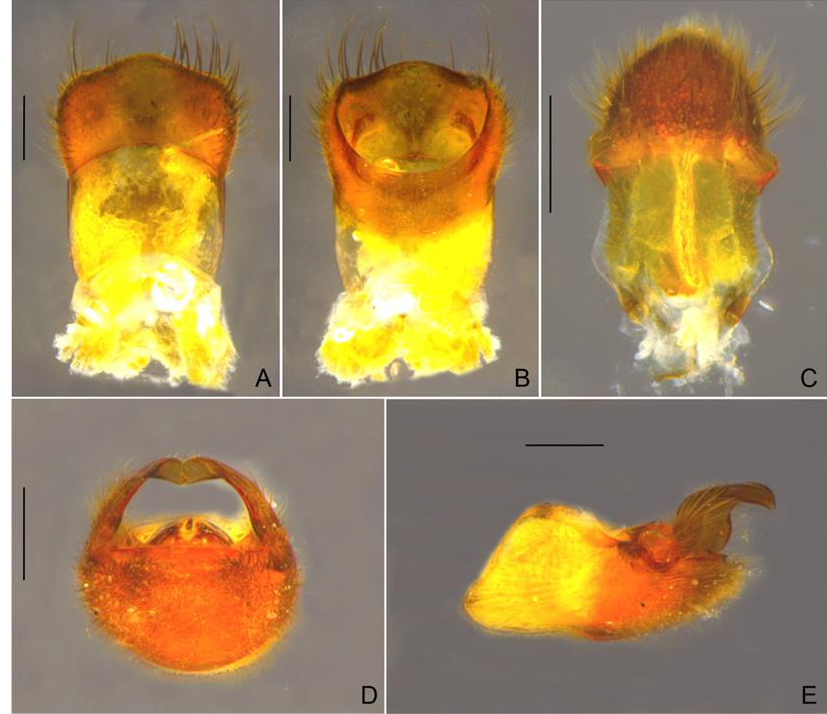
Figure 3. Paravelia luisi sp. nov., male terminalia. ( A , B ). Abdominal segment VIII. ( A ). Dorsal view. ( B ). Ventral view. ( C ). Proctiger, dorsal view. ( D , E ). Genital capsule. ( D ). Anterior view. ( E ). Lateral view. Scale bars: 0.2 mm.